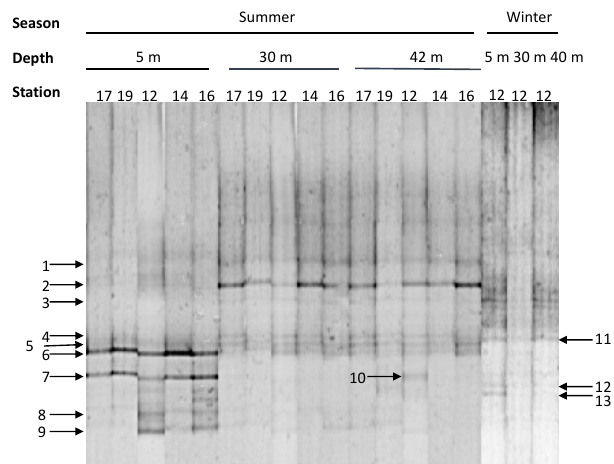
Figure 7. DGGE profile of 16S rRNA gene fragments of samples from different depth and stations in the central North Sea. Numbers on the lines indicate excised and successfully sequenced DGGE bands, whose phylogenetic assignment is listed in Table